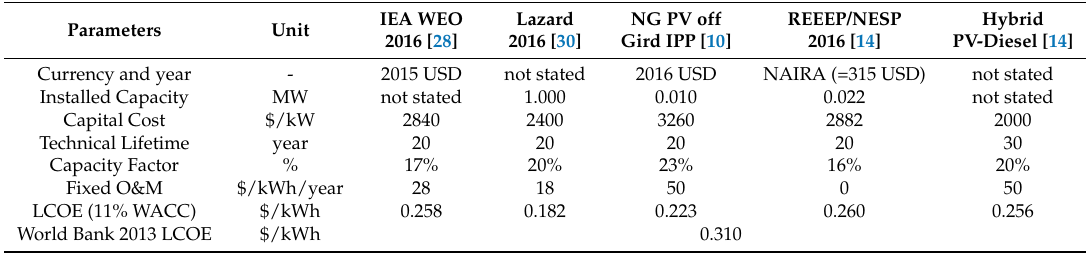
Table 3. PV off-grid rooftop (Residential, C&I)—few kw to few mw storage included source [14,44,46].